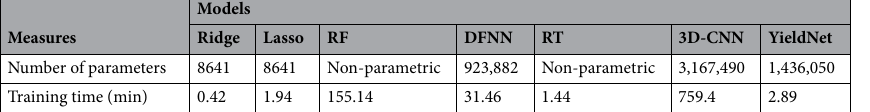
Table 6. The number of parameters and training time of the competing methods for crop yield prediction. The training time indicates the total time needed for training models for both corn and soybean yield prediction. The models were trained on an Intel i7-4790 CPU 3.60 GHz.